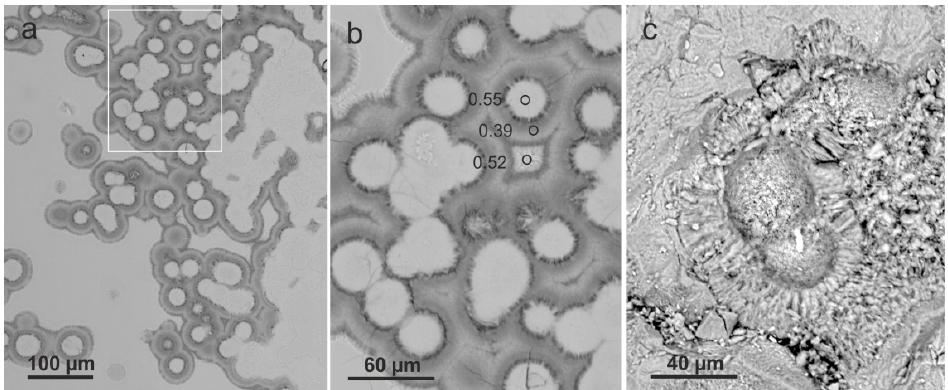
Figure 7. SEM-micrographs showing the appearance of opal-CT in agate sample ACu3: ( a ) a SEM- BSE image of the spherical opal-CT aggregates; ( b ) a close-up of ( a ) (see rectangle) with details and results of local chemical analyses of Al (in wt%) by SEM-EDX; ( c ) a SEM composite micrograph of opal-CT lepispheres revealing the characteristic spheres consisting of small crystal blades.